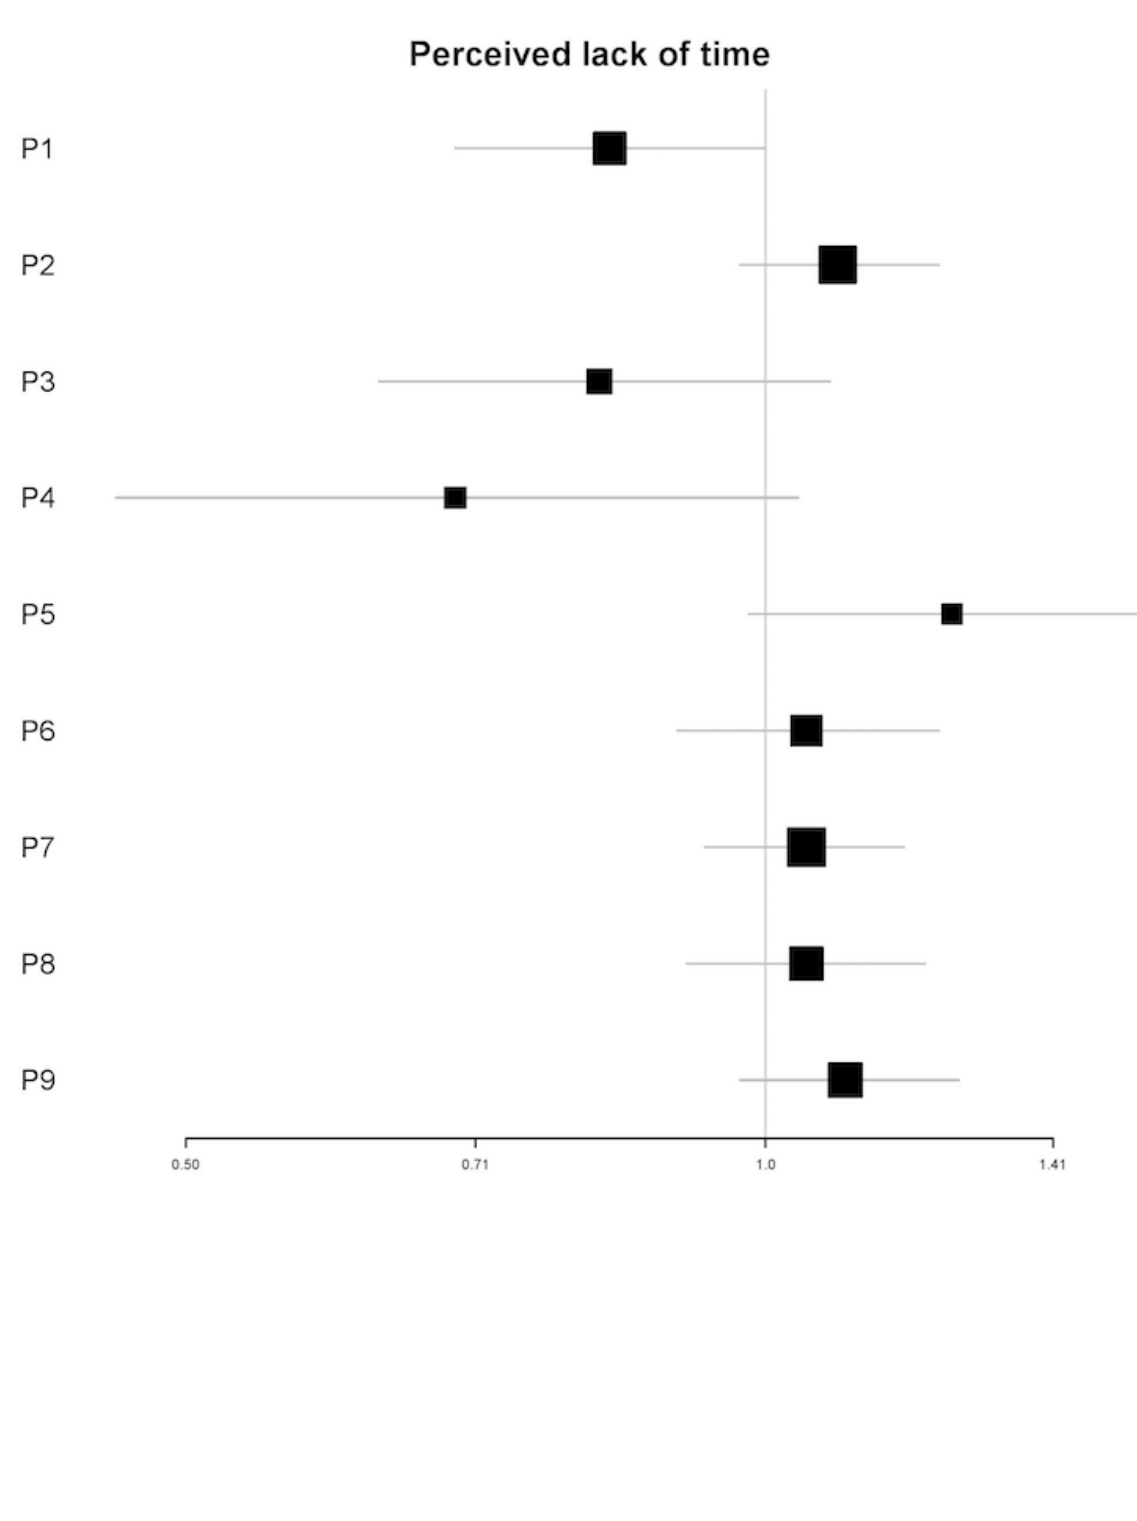
Figure 9. Plot of incidence rate ratios and 95% CIs (x-axis) for the association of perceived lack of time and the frequency of engagement for each participant (y-axis) in univariable analyses. P: